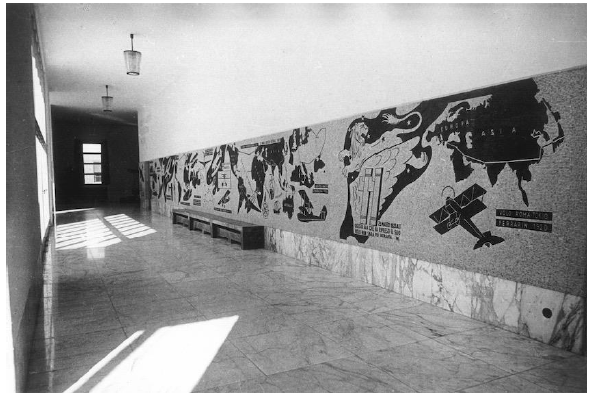
Figure 2. Former Aeronautical College. Mosaics. ©Archivio Valle, Roma, scatola 26, CV-FOT/061